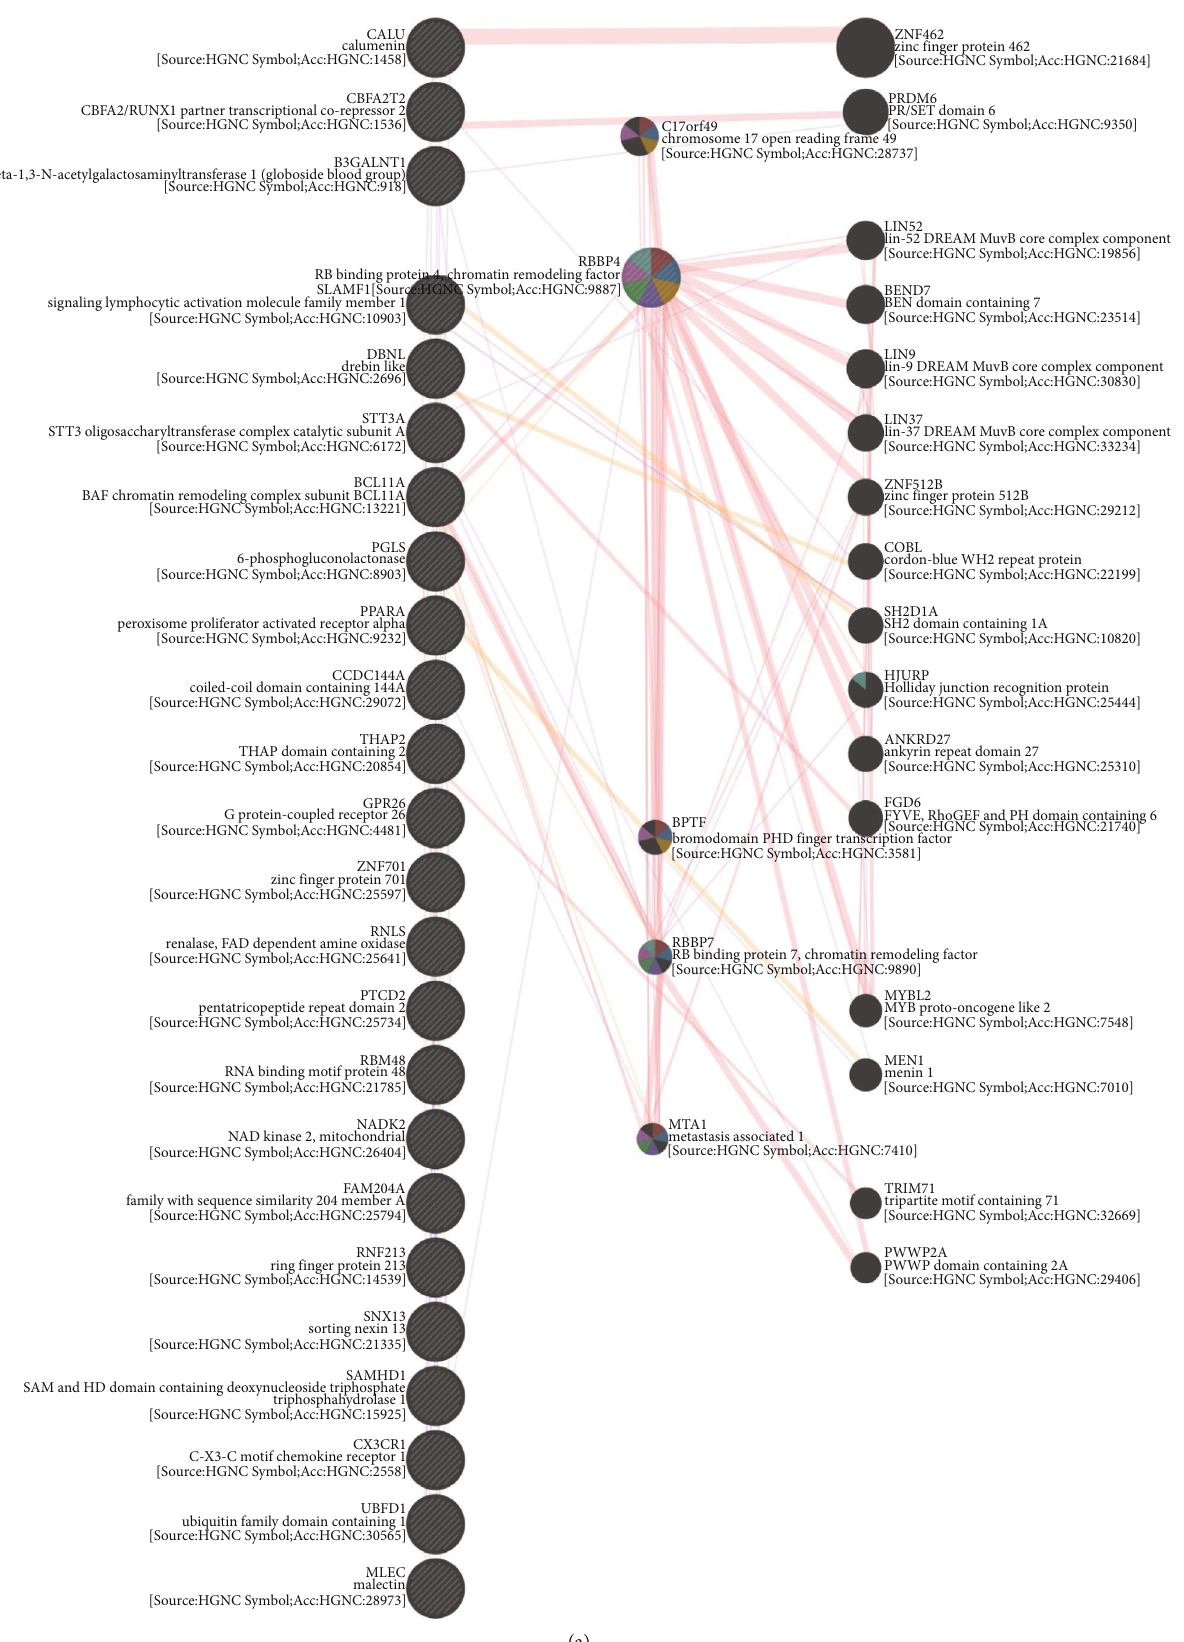
alphaBAF 144A6-phosphogluconolactonase peroxisome proliferator activated receptor